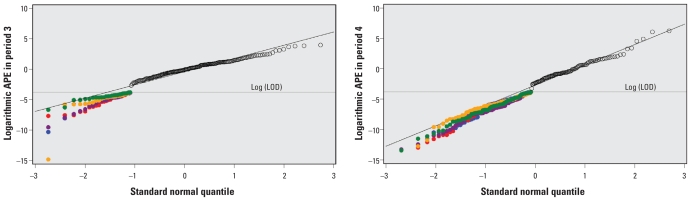
Normal Q-Q plots for logarithmic APE in periods 3 and 4 normal Q-Q plots of the observed log(APE) values [> log(LOD)] and the imputed APE values [< log(LOD)] from each imputed data set for period 3 (A) and period 4 (B). The observed values > log(LOD) [open circles, above the log(LOD) reference line] are identical for all five data sets. Imputed values < log(LOD) differ between the data sets (indicated by different-colored dots). Diagonal reference lines indicate the estimated bivariate normal distribution based on MLEs for each period. For simplicity, reference lines for the estimated distributions from the five imputed data sets are not shown.